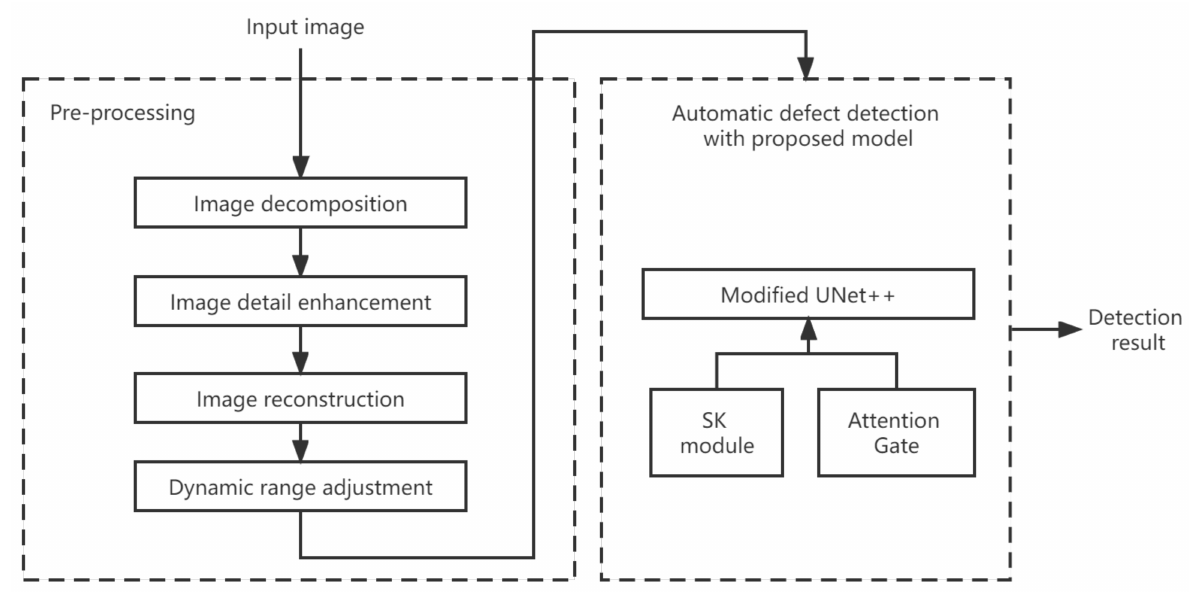
Figure 1. The flow chart of the entire defect detection